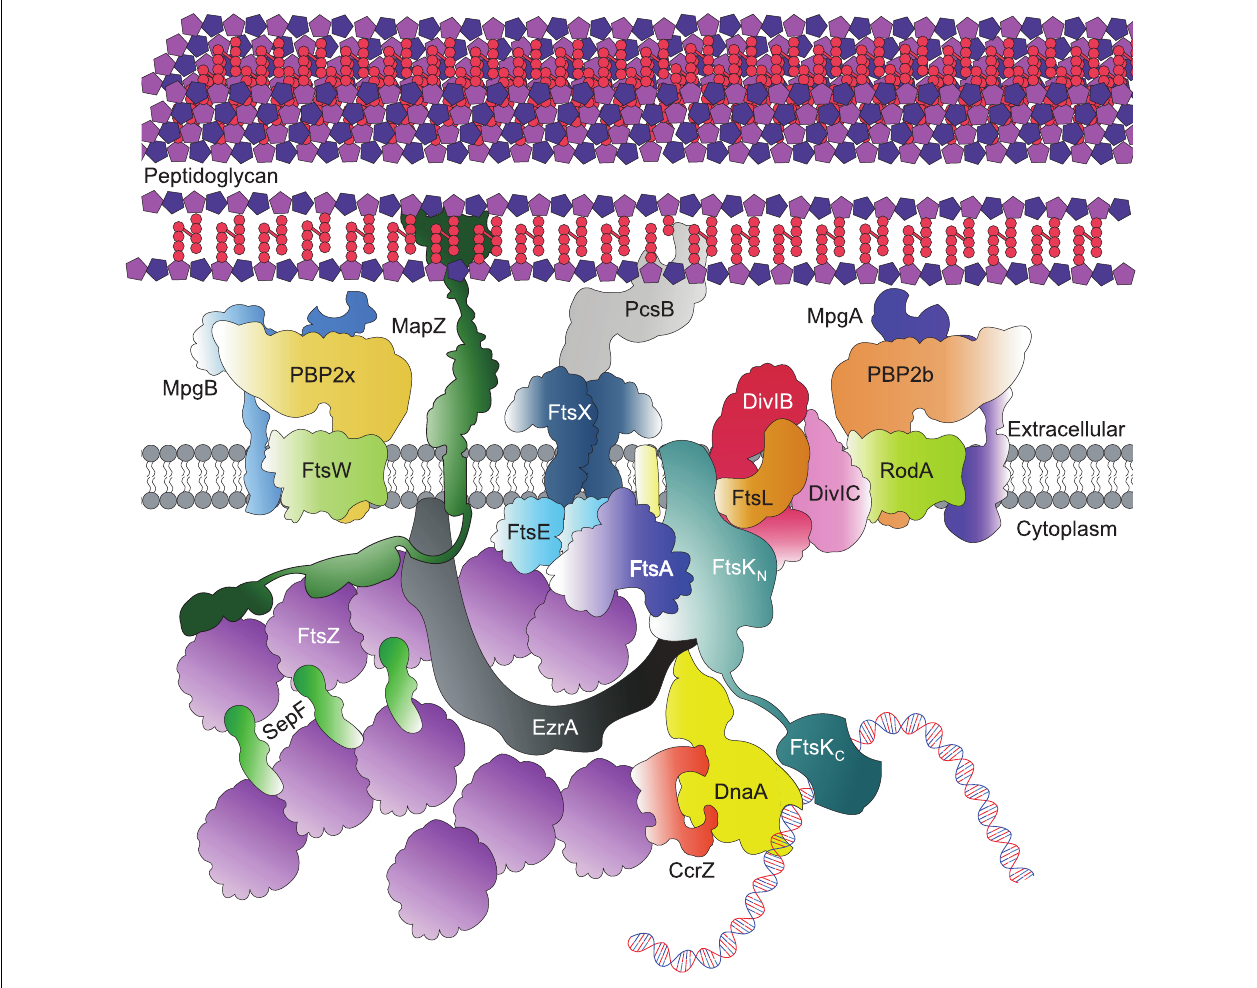
FIGURE 2 | Core pneumococcal divisome components at equators of predivisional cells. For simplicity, components that localise to the equatorial ring, including Class A PBPs, the Rod complex and regulatory proteins are not shown here; but depicted in Figure 3